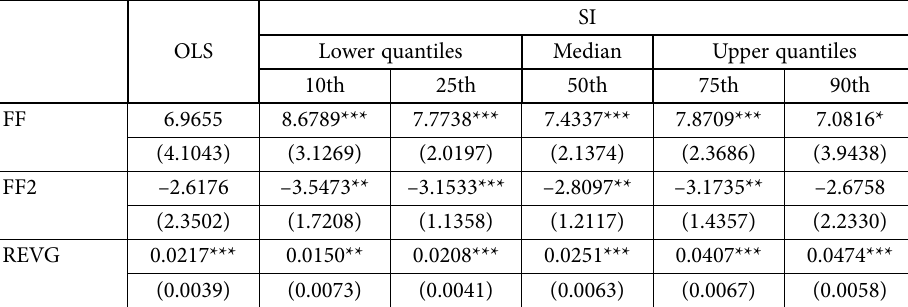
Table 12. OLS and QR results for the SI using